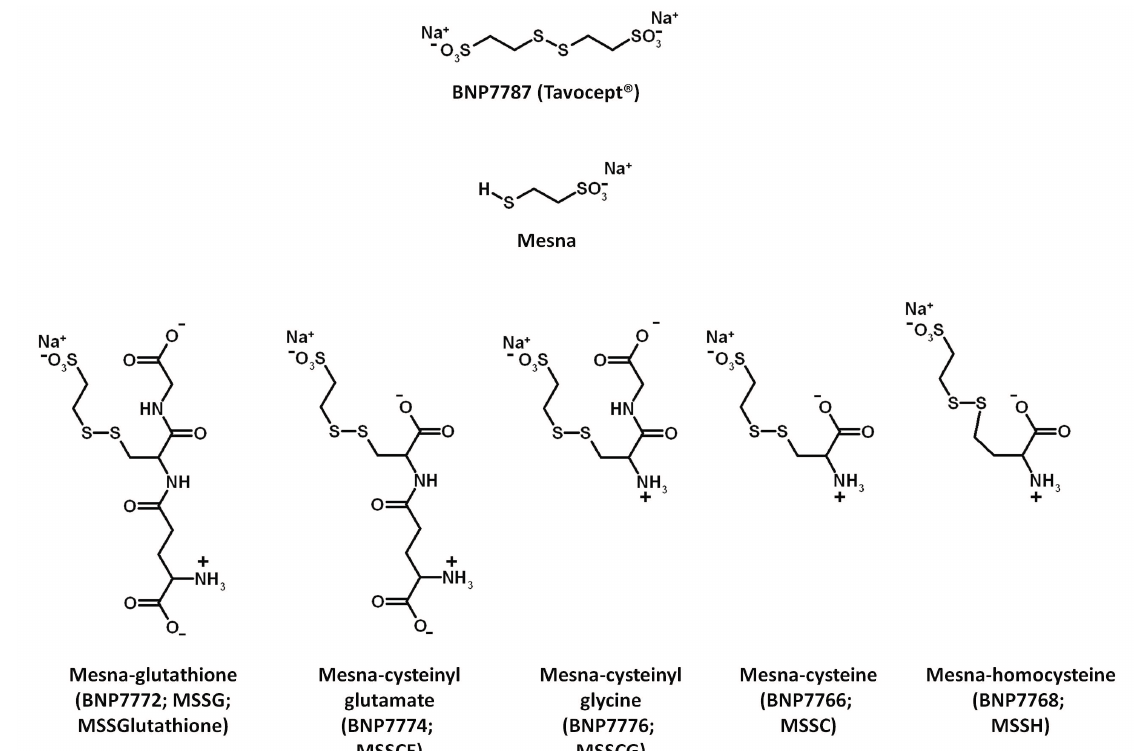
Figure 1. Structures of BNP7787, Mesna, and BNP7787-derived mesna-disulfide